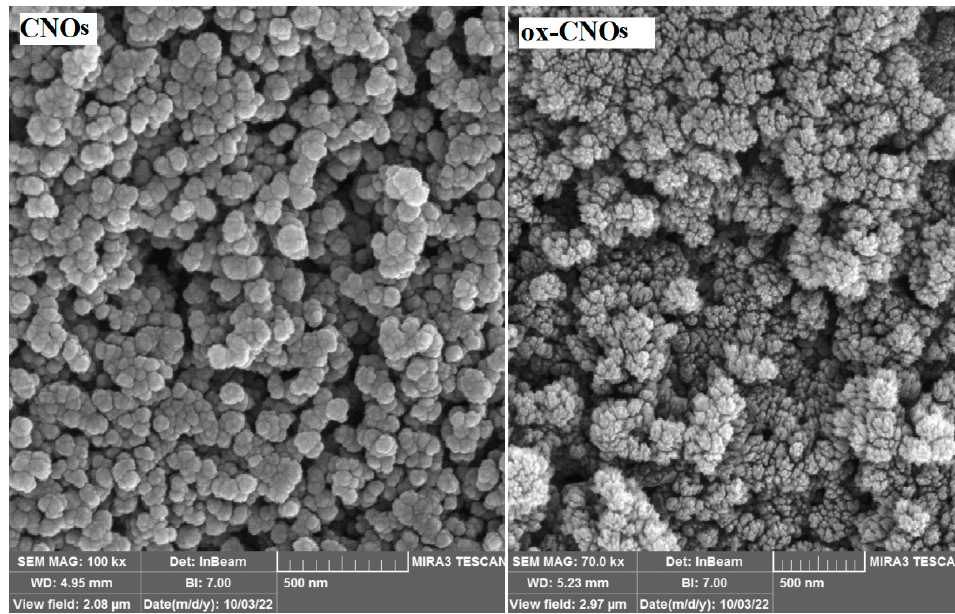
Figure 2. FE-SEM image of CNOs and ox-CNOs.